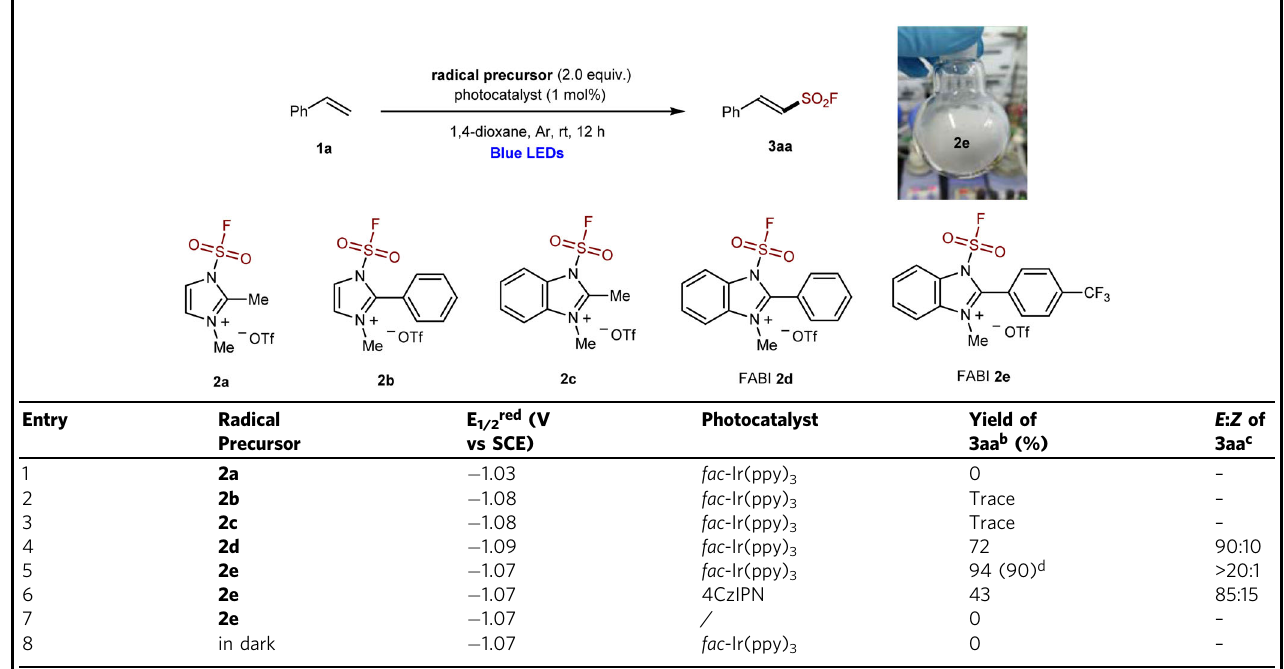
Table 1 Reaction optimization for the radical fl uorosulfonylation of styrene with FABI salts as a radical precursor a